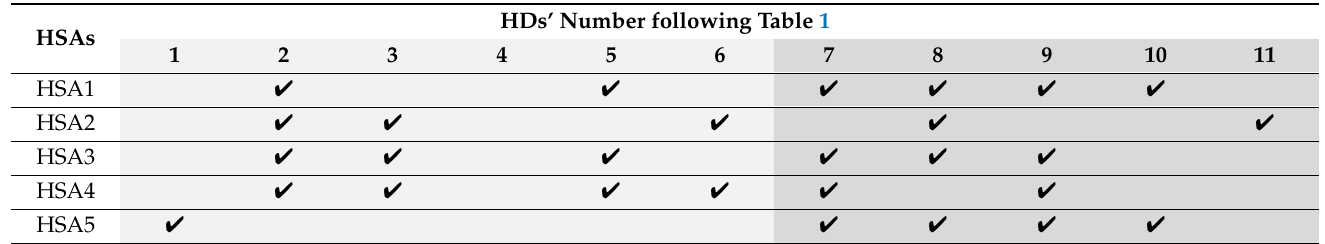
Table 2. The diagnostic checklist to recognize the presented HSAs in TBs. (cid:52) : Included in the